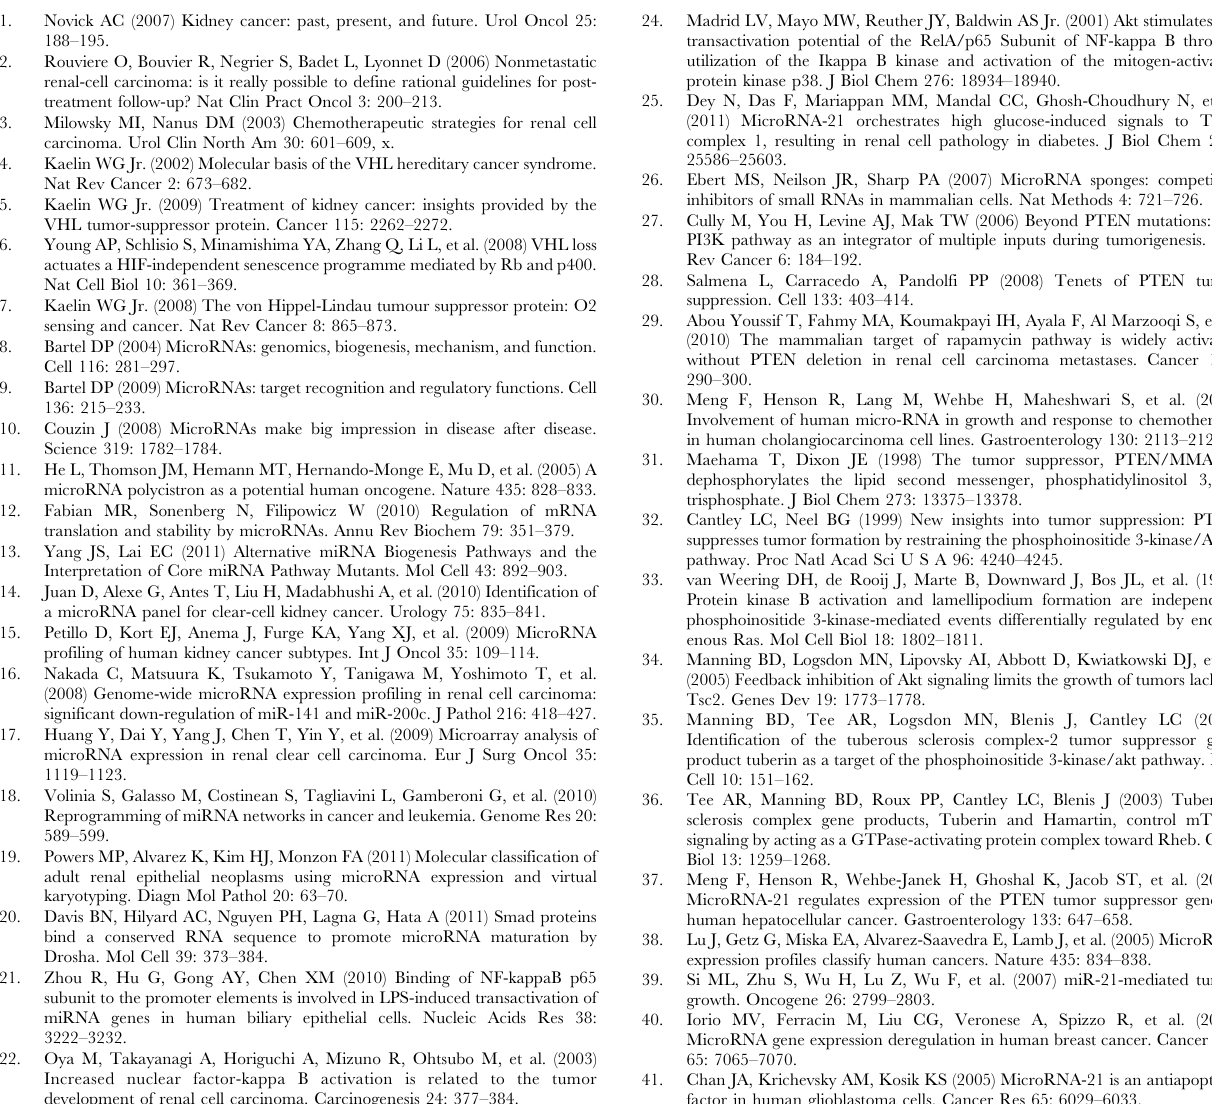
Figure S25 (A) Expression of constitutively active Gag-Akt reversed miR-21 Sponge-induced inhibition of migration of BT-20 human breast cancer cells. BT-20 cells were transfected either with miR-21 Sponge alone or along with Gag-Akt expression plasmid. the legend of Fig. 2C. (B) The absorbance of the stain of the migrated cells in panel A was determined. Mean 6 SE of